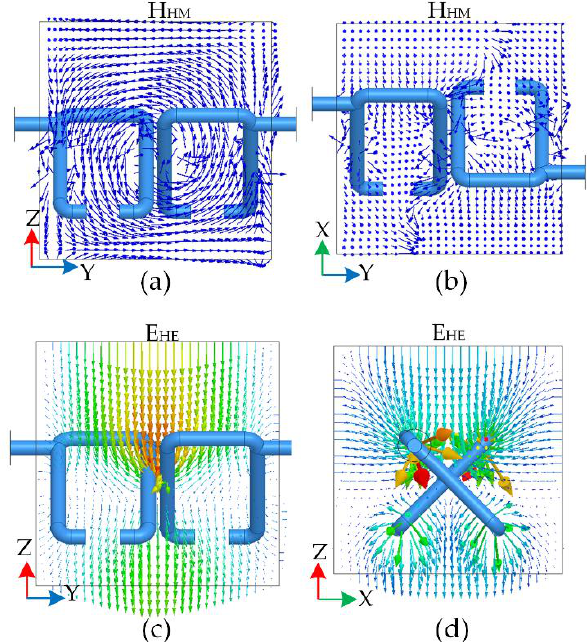
Figure 2. Field distributions of the resonant modes ( a ) H-field distributions of hybrid magnetic (HM) mode at O–O’ cut-plane; ( b ) H-field distributions of HM mode at Q–Q’ cut-plane; ( c ) E-field distributions of hybrid electric (HE) mode at O–O’ cut-plane; ( d ) E-field distributions of HE mode at P–P’ cut-plane.